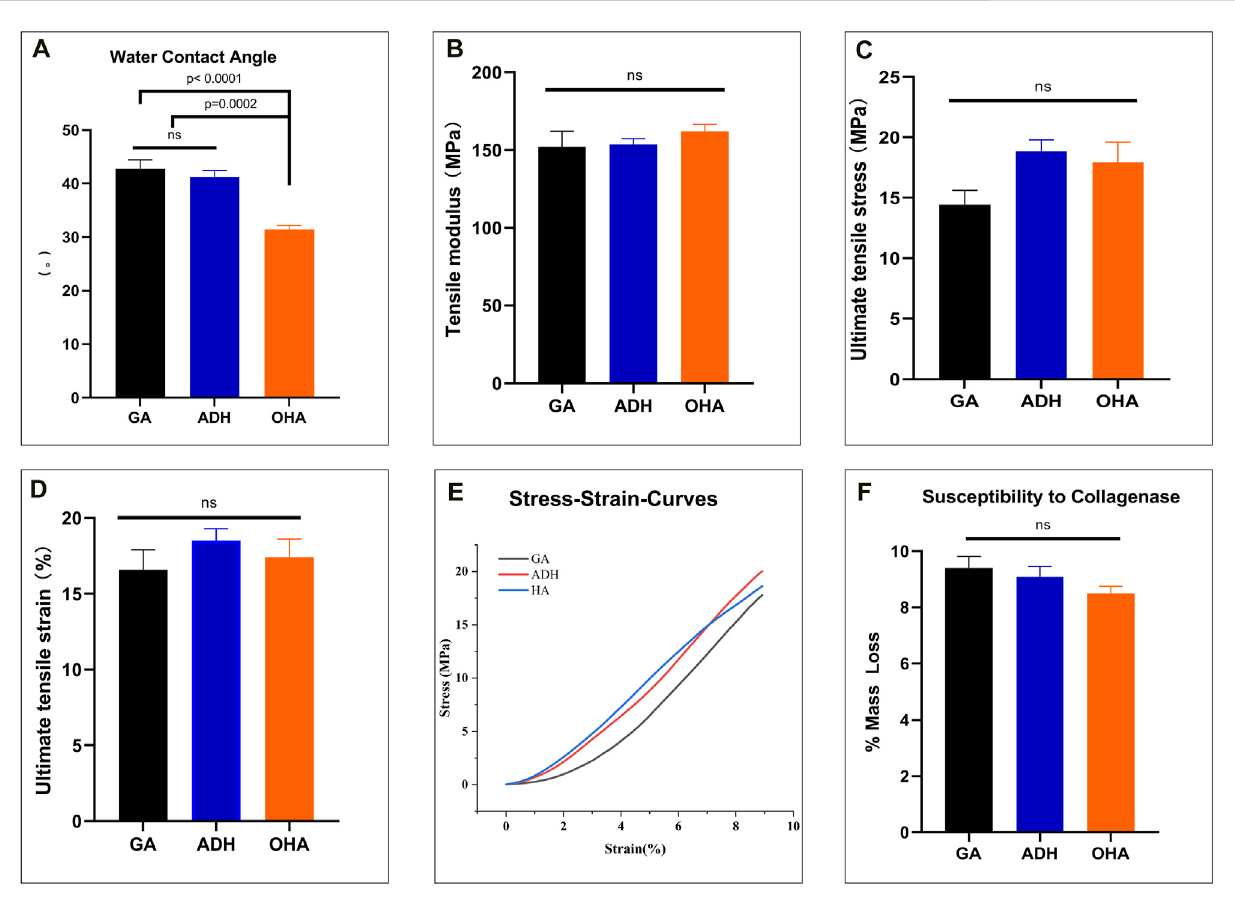
FIGURE 4 The water contact angle, biomechanical properties and susceptibility to collagenase of the three groups. The water contact angle of the lea fl ets decreased signi fi cantly in the OHA group compared with those of the GA and ADH groups (A) . There was signi fi cant improvement in the NPTD group compared with the GA group (D) . The tensile modulus of the linear region (B) , ultimate tensile stress (C) and ultimate tensile strain (D) among the three groupswerenosigni fi cantdifference.Therepresentativestress ‒ straincurvesofeachgrouparepresented (E) .Therewasnodifferenceintherelative mass loss among the three groups (F)